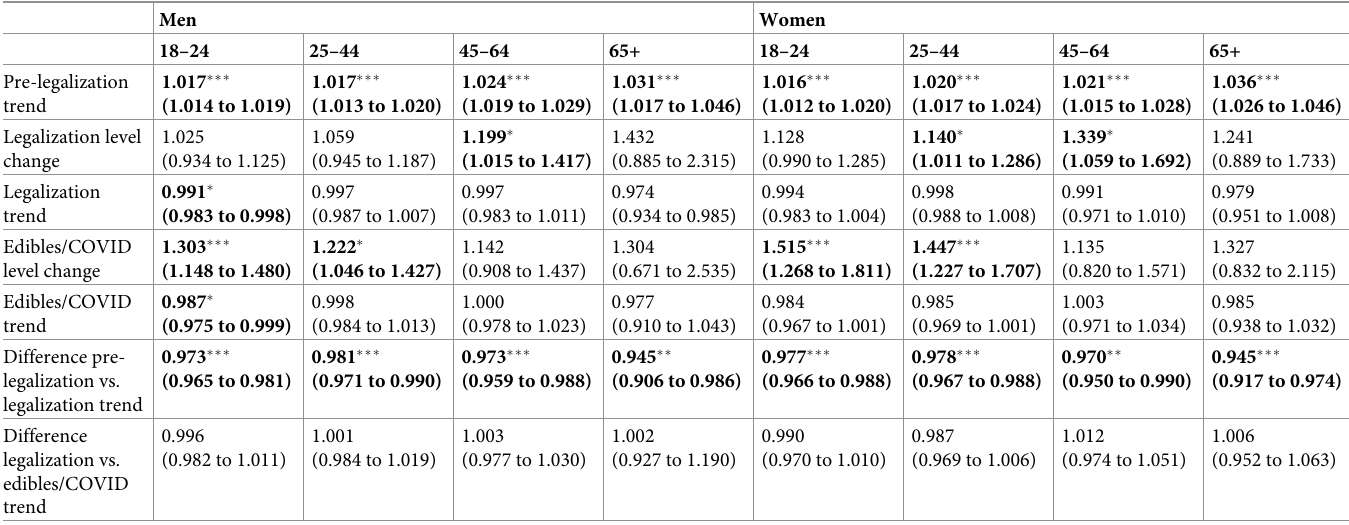
Table 5. Associations between cannabis policies and ED visits in all of Ontario using negative binomial regression with censored months in the early stages of COVID-19